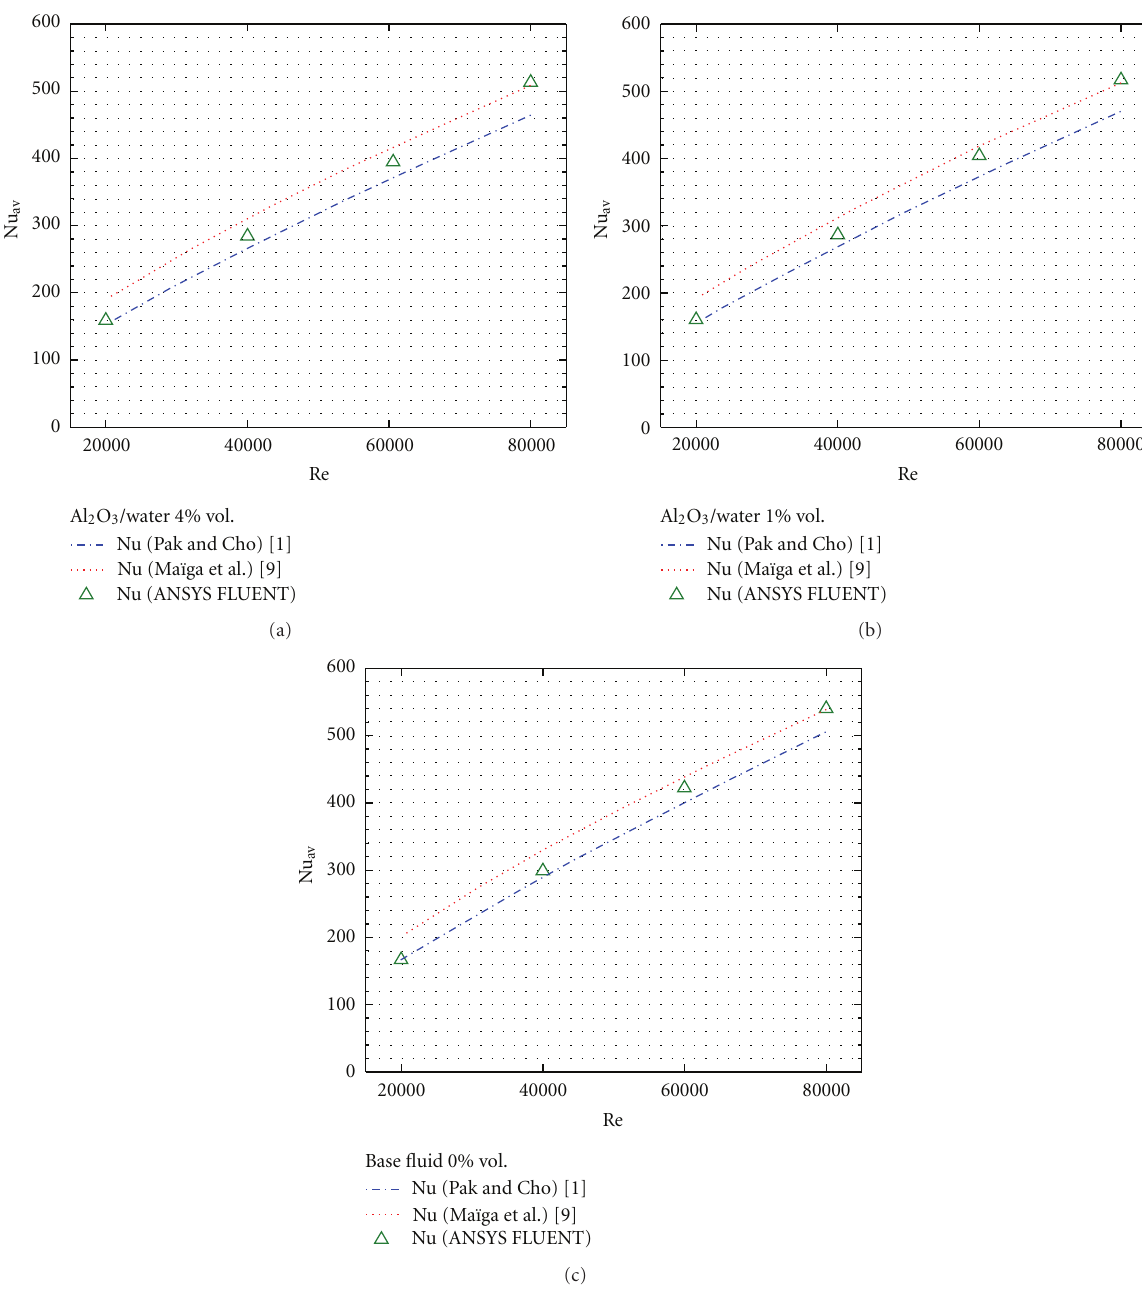
Figure 9: Comparison of average Nu with the